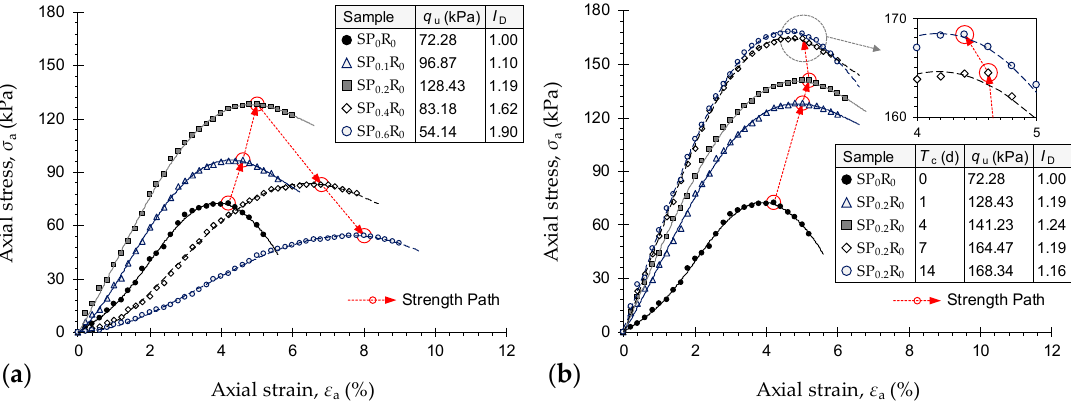
Figure 5. Stress–strain curves for the natural soil and various PAM-treated samples: ( a ) SP x R 0 , at T c = 1 d, where x = {0, 0.1, 0.2, 0.4, 0.6}; and ( b ) SP 0.2 R 0 at T c = 1, 4, 7 and 14 d.